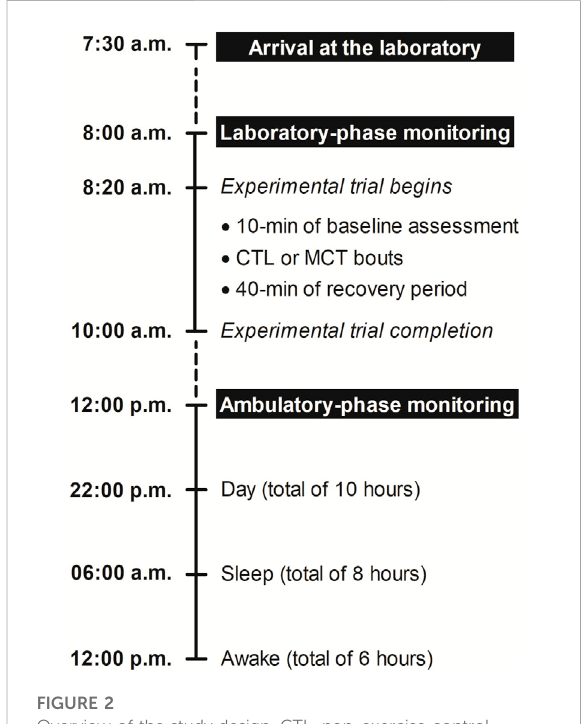
FIGURE 2 Overview of the study design. CTL, non-exercise control session; MCT, mixed circuit